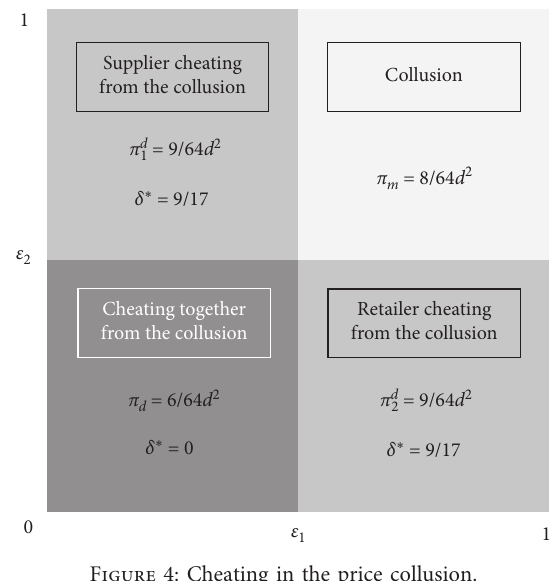
Figure 4: Cheating in the price